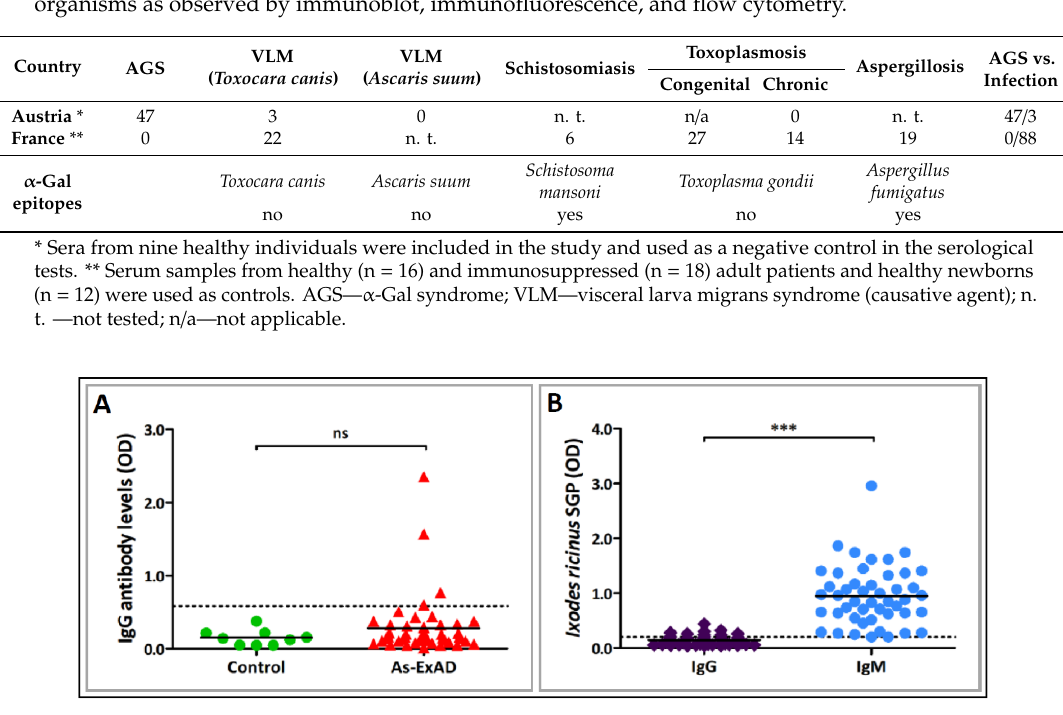
Figure 4. Reactivity of serum antibodies to Ascaris suum and Ixodes ricinus ticks in patients with α -Gal